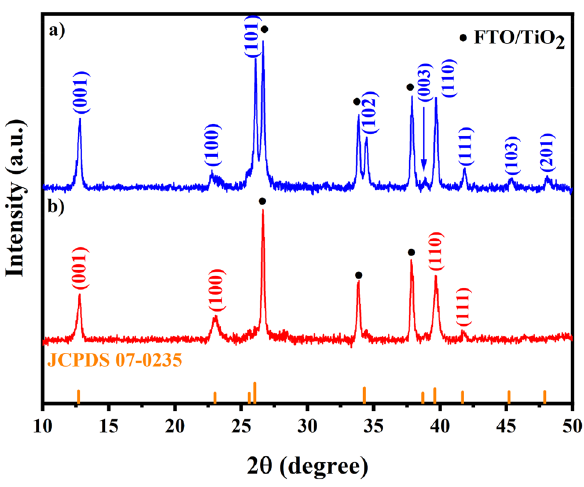
Figure 2. XRD patterns of PbI 2 films obtained from iodination of chemically deposited PbS films at ( a ) 120 and ( b ) 155 °C.